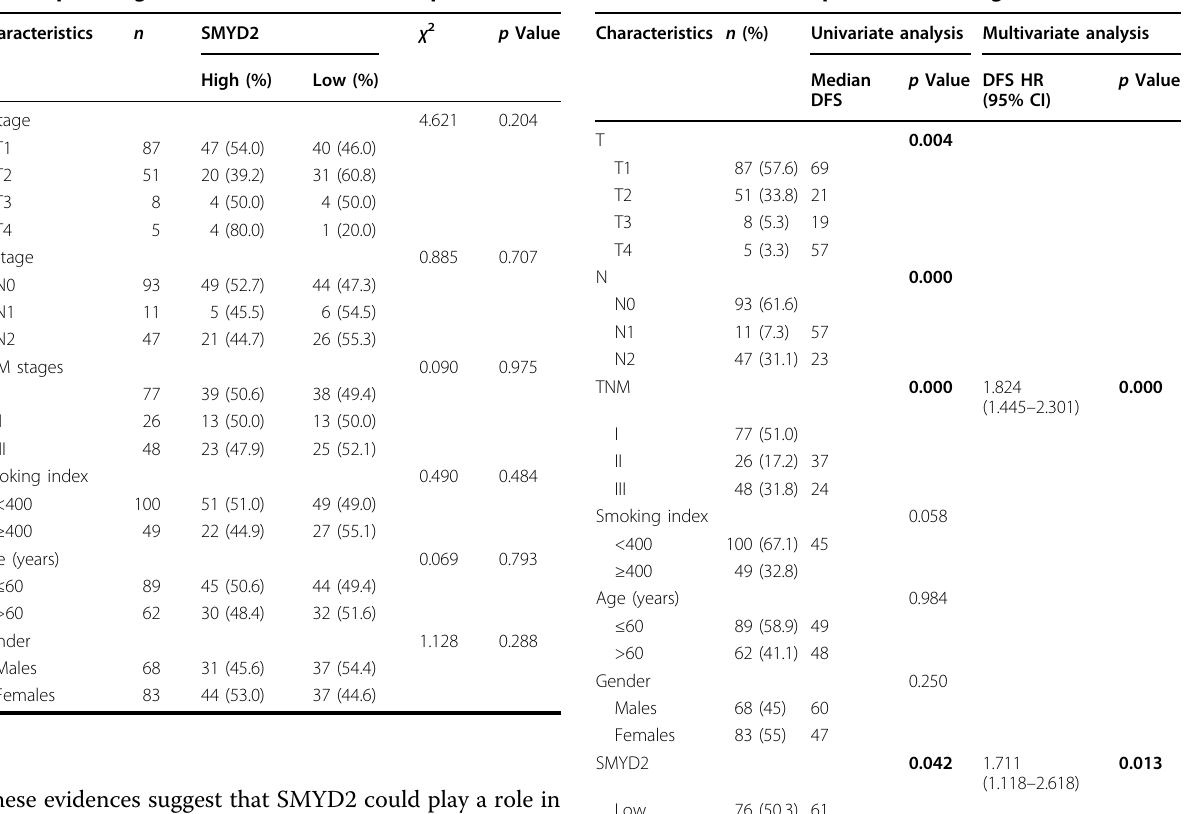
Table 2 Univariate and multivariate analysis between clinical and survival in patients with lung